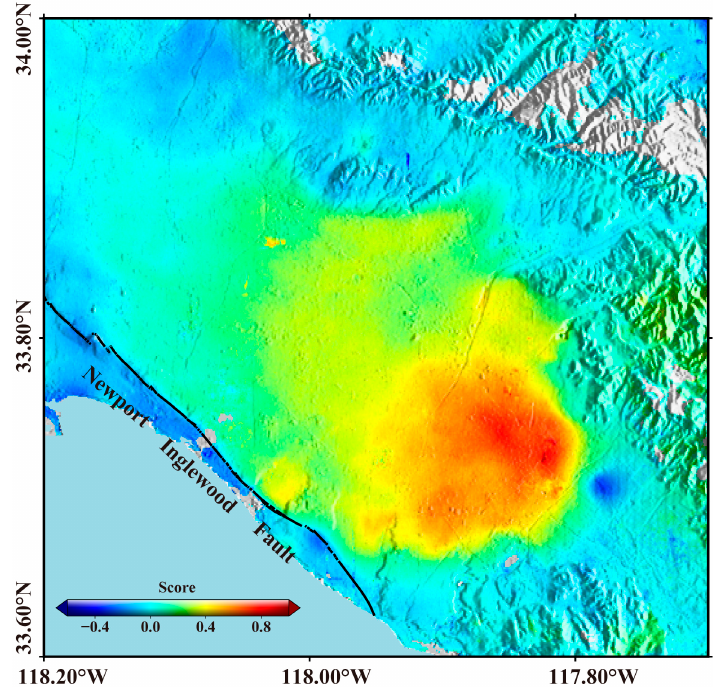
Figure 12. Local map of IC1 score values around the NIF.